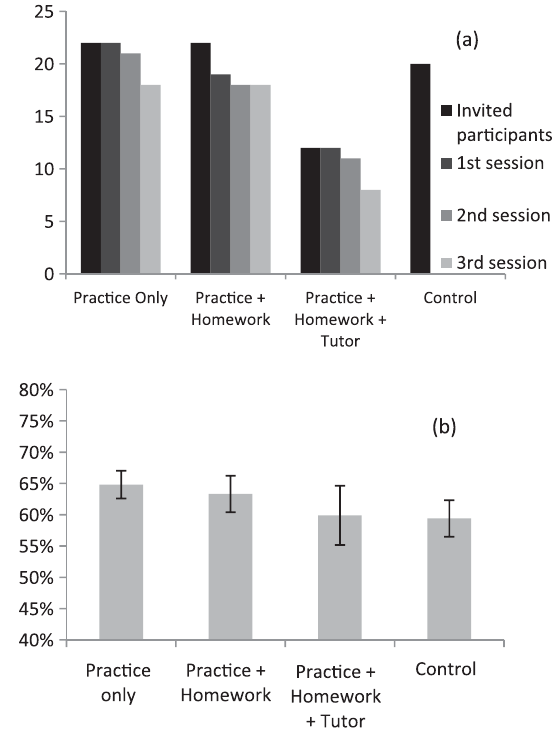
FIG. 1. Experiment setting. The sequence of the activities of each group flowed from top to bottom. Participants in each group received one type of treatment throughout the experiment.